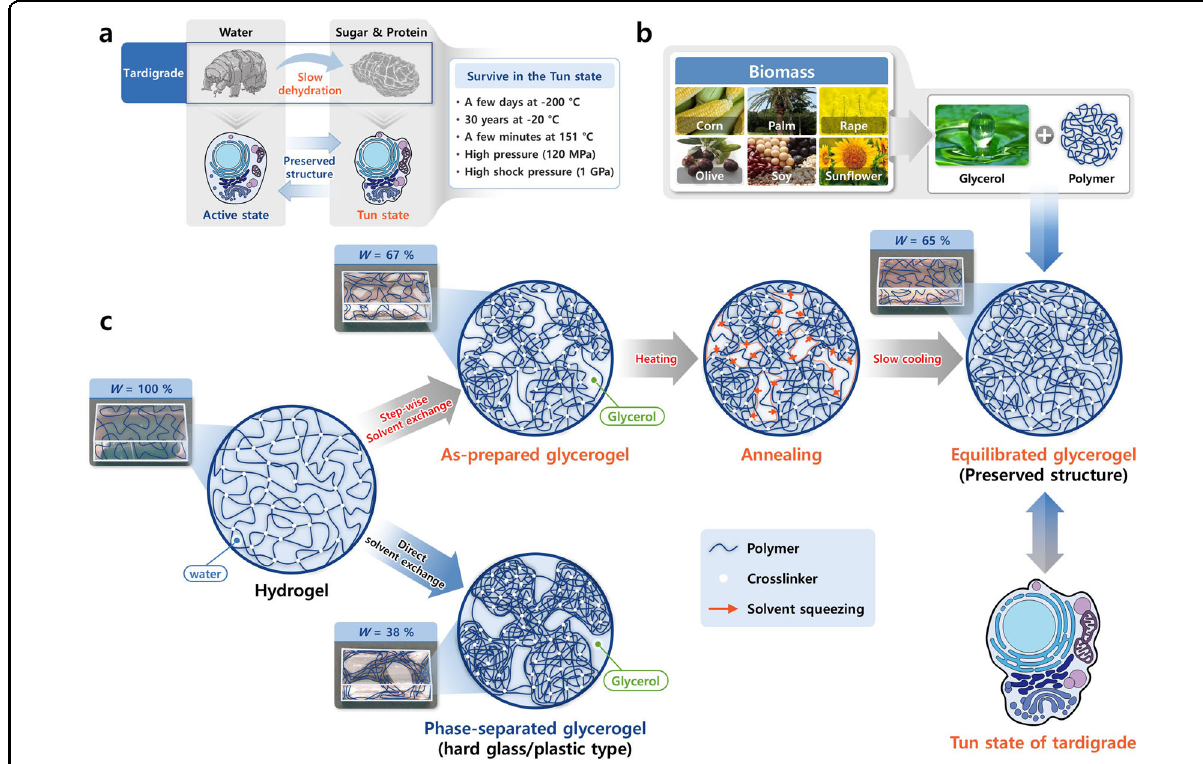
Fig. 1 Tardigrade-inspired strategy for designing extremotolerant GGs. a Tardigrades transform to the tun state under extreme conditions by preserving their integral structure because they withstand various harsh environmental conditions. b Inspired by the tun formation of tardigrades, extremotolerant multifunctional GGs are designed by integrating various polymers with glycerol, which is a biofriendly solvent 33 . c Initially, the water in the predesigned functional hydrogels is sequentially replaced with glycerol to minimize the damage to the integral structure of the gel. Thereafter, the as-prepared GG is dry-annealed to release undesired residual stresses and to obtain the fi nal GG with a preserved polymer structure, mimicking tun formation in tardigrades. In contrast, direct solvent exchange results in a phase-separated hard structure inside the gel